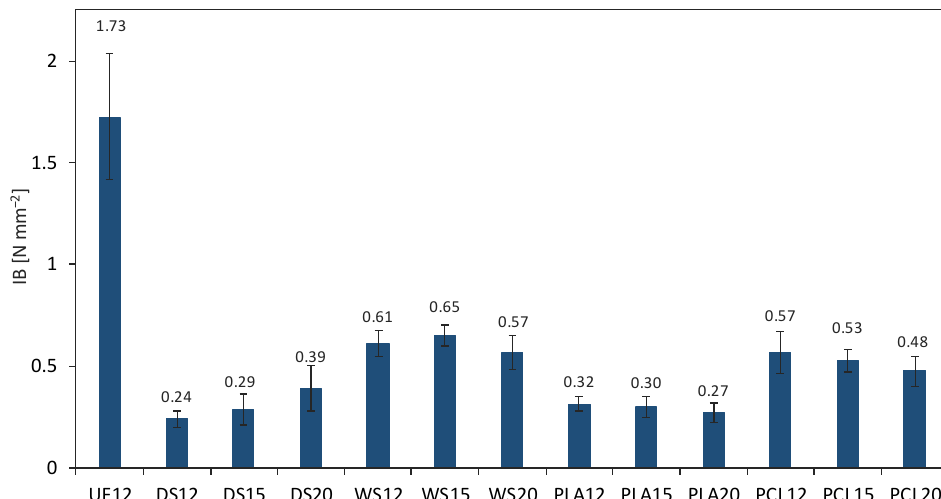
Figure 4. Internal bond (IB) of tested HDF.